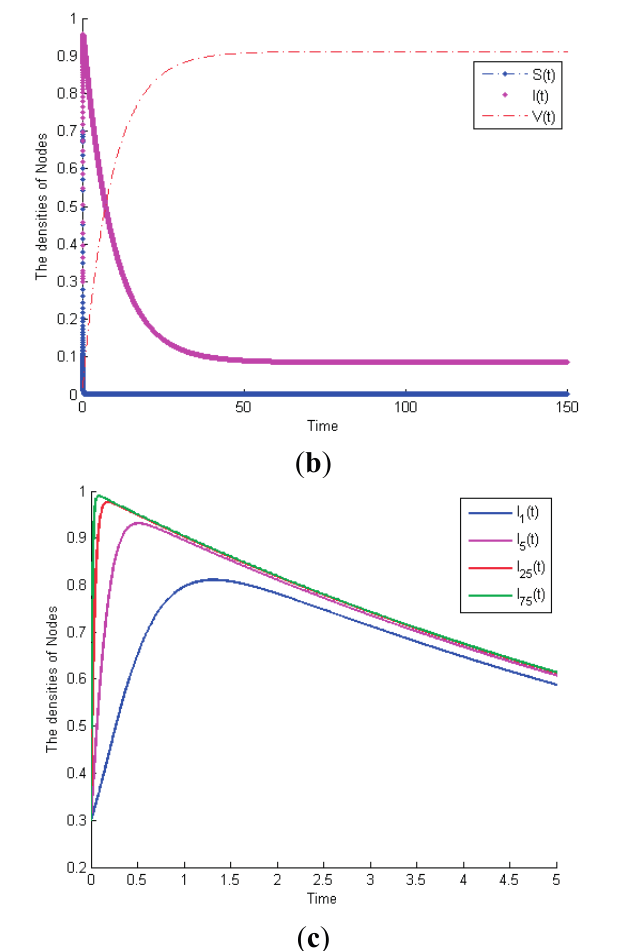
Figure 3. ( a ) Globally asymptotically stable of worm-free equilibrium of System (1) when 0.2884 1 R   . ( b ) Malicious worms of System (1) are prevalent when 01 ( c ) The time plot of different node degrees of malicious infectious nodes.